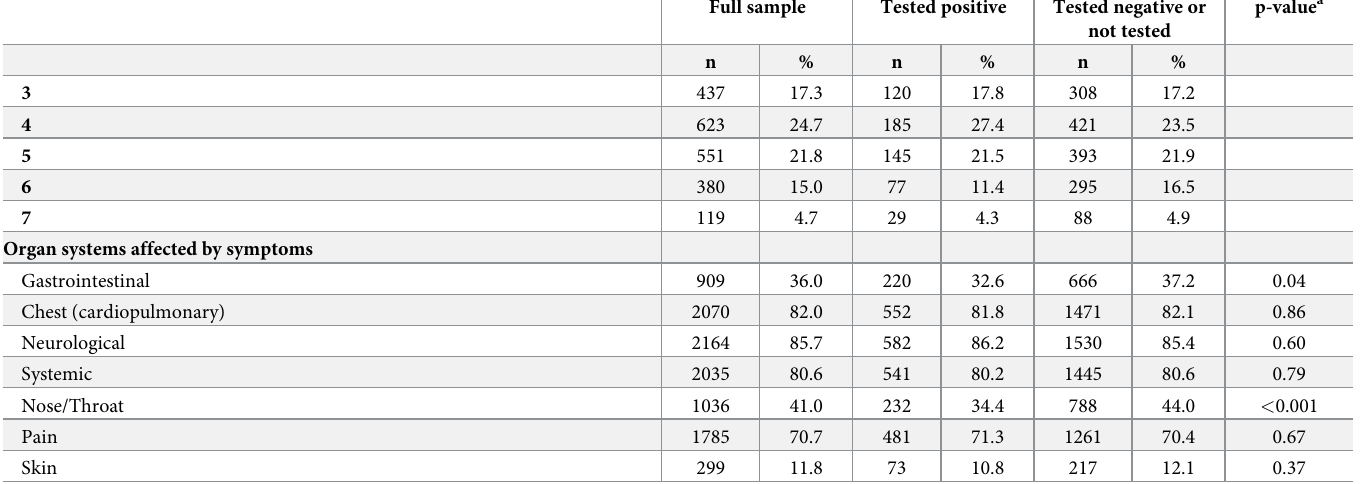
cognitive dysfunction was present in the initial first two weeks and persisted throughout the illness in 36.9% of participants but was also reported as new symptom(s) after the acute phase of the illness in 32.3% of participants, including brain fog (36.1%), memory problems (30.7%), and poor concentration (27.4%) (S3 Table).